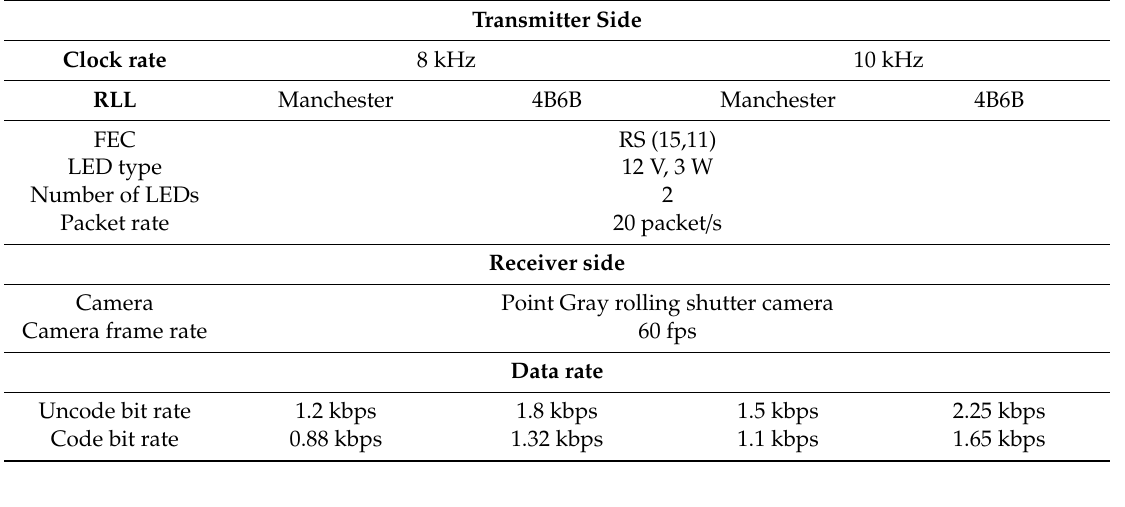
Table 2. MIMO–COOK parameters.